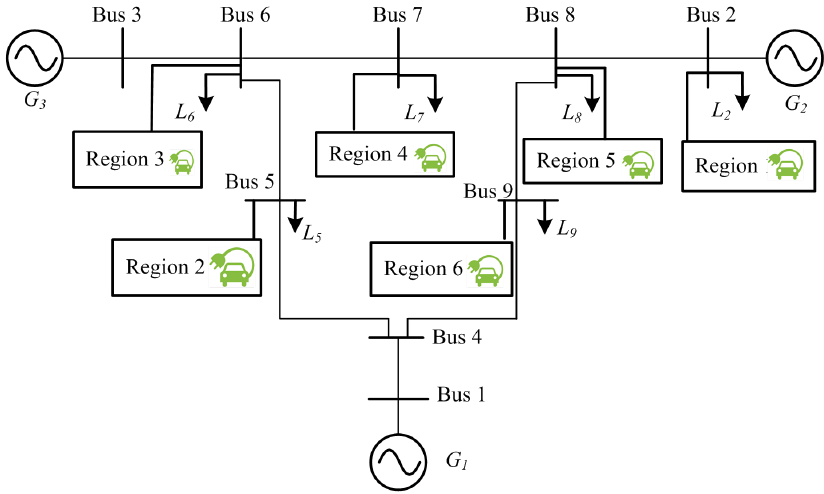
Figure 8. One line diagram of modified IEEE 9-bus test system. Table 2. Load demand and maximum capacity of electric vehicle charging stations at each bus.